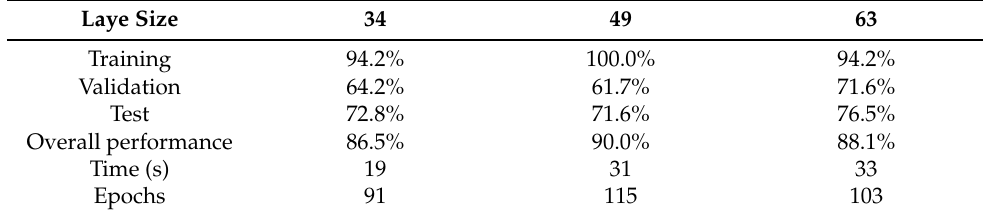
Table 3. Results of the ANNs with the complete FFT.